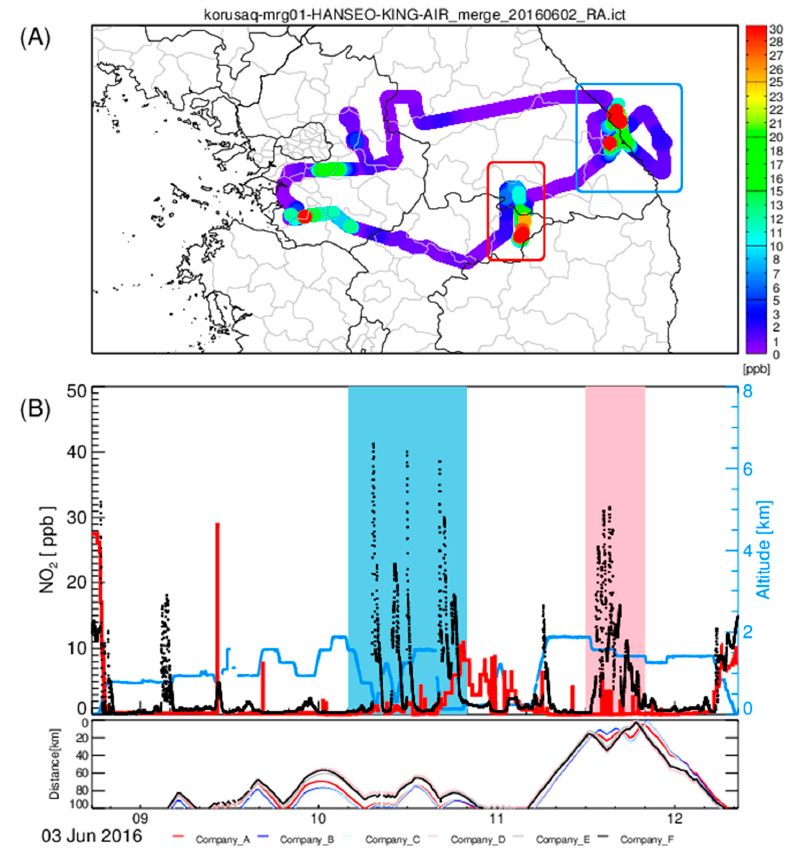
Figure 6. ( A ) Spatial distribution and ( B ) time series of NO 2 concentration measured by King-Air aircraft on 3 June 2016 during the KORea-United States Air Quality Study (KORUS-AQ) field campaign. The thick red line shows modeled NO 2 concentrations from the CMAQ model. Distances from the aircraft to six YDJ cement factories are shown in the bottom panel.